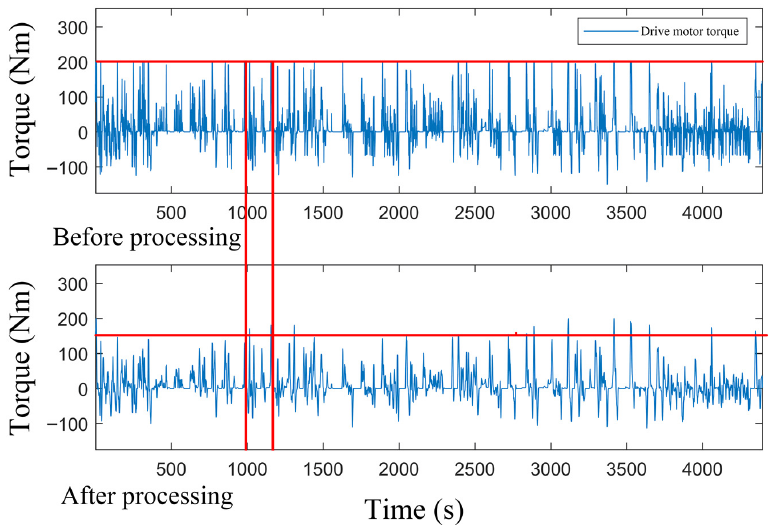
Figure 3. Comparison diagram of singular point removal of engine torque load data in urban con- ditions.